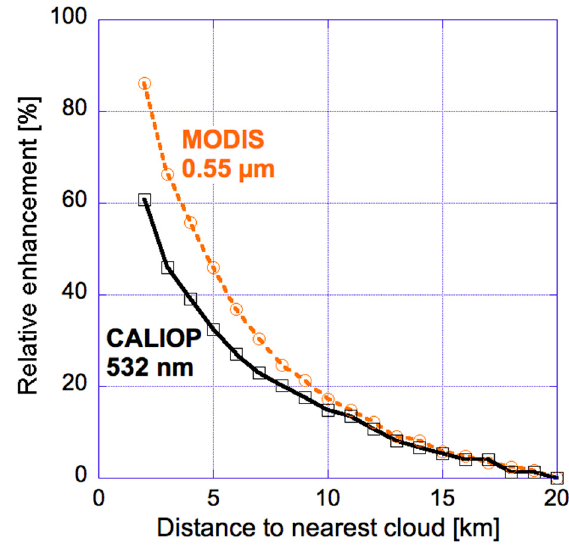
Figure 7. Median near-cloud relative enhancements in particle scattering, as observed by MODIS and CALIOP over all oceans between 60° N and 60° S. Relative enhancements are calculated as 100 ( X − X 20km )/ X 20km , with X being R p or β p for the two curves, respectively. The figure is based on Figure 4 of [47].